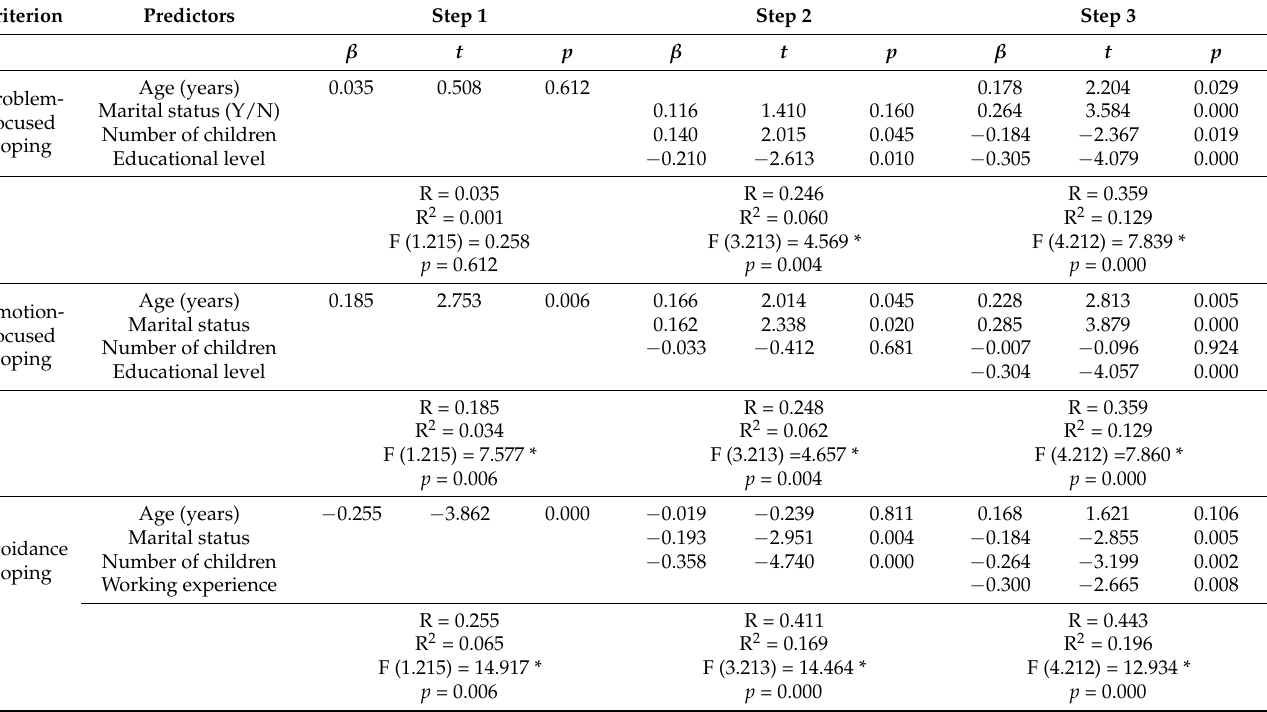
Table 4. Results of the stepwise regression analysis using coping strategies as a criterion in CoV